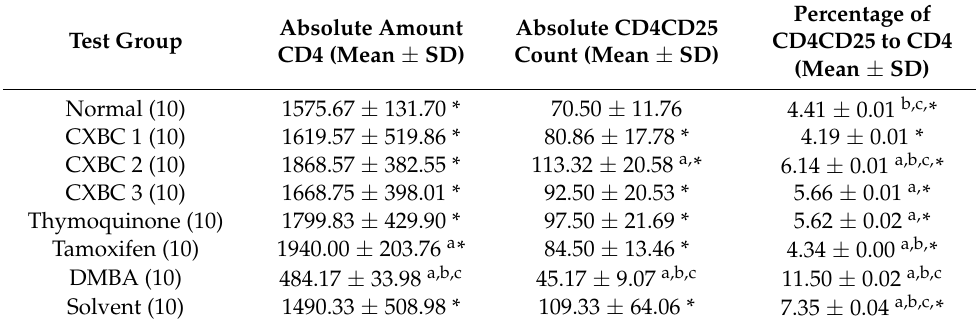
Table 8. Examination results of the absolute number of CD4 lymphocytes in the peripheral blood of SD rats induced with DMBA at 2 × 20 mg/kg/week for five weeks after receiving seven weeks of CXBCH treatment. Blood sampling was carried out at the 30th week of the experiment.